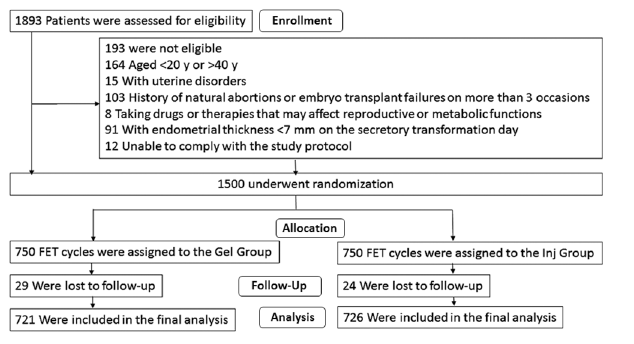
Fig 1. Study protocol.